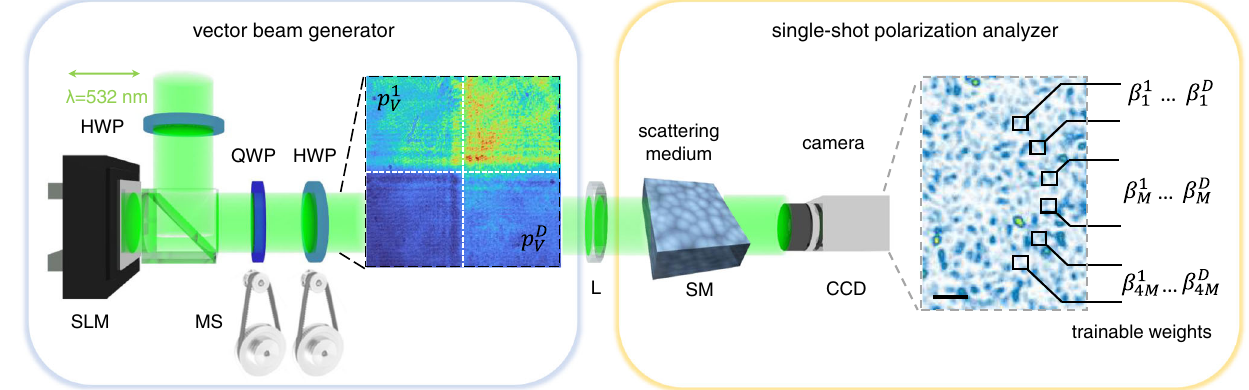
Fig. 2 | Experimental setup. The vector beam generator is based on a phase-only spatiallight modulator (SLM). Insetshows the verticalintensitycomponent p V of a partitionedbeamcomposedoffourSOP.Theapparatusforsingle-shotpolarimetry iscomposedofascatteringmedium(SM)andacamera(CCD).Thecollectedspatial